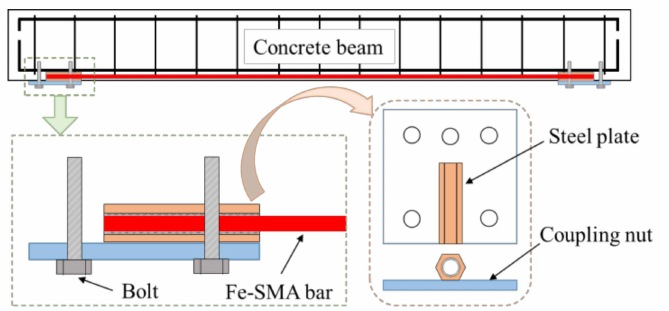
Figure 10. Details of anchorage mechanism